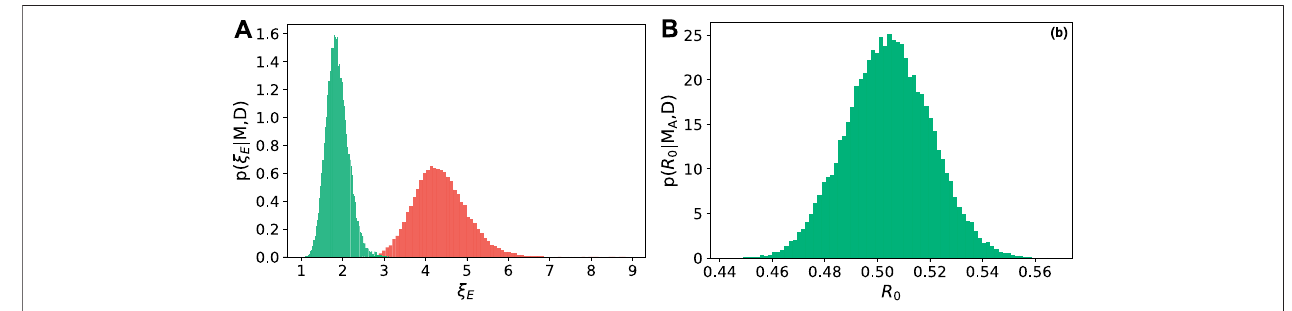
FIGURE8|(A) Marginalposteriordistributionsfor ξ E conditionalondata D andmodels M R (red)and M A (green). (B) Marginalposteriordistributionfor R 0 conditional on data D and model M A . The data D consist of the collective use of the CoMP data set analysed by Verth et al. (2010). The posterior summaries are ^ ξ MAP E (cid:2) 4.3 + 0 . 7 − 0 . 6 for